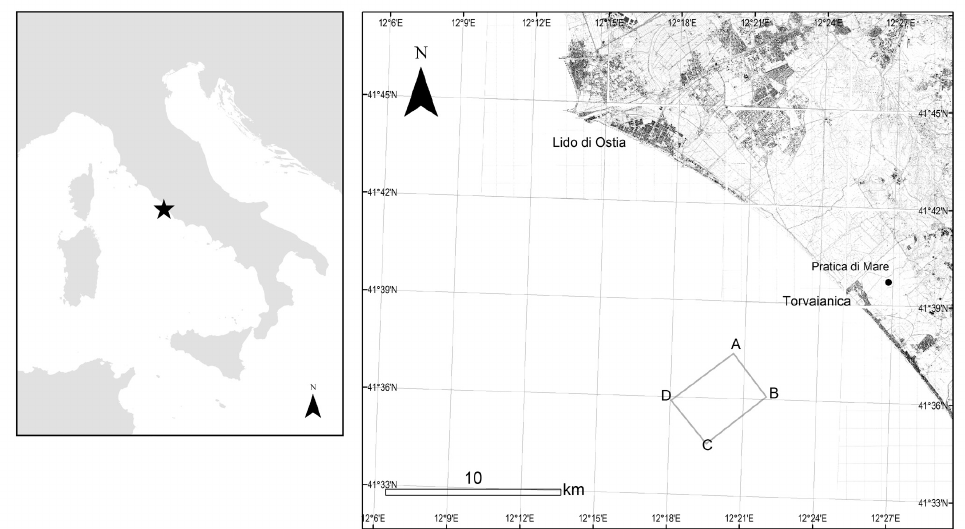
Fig. 1 – Study area; the rectangle A-B-C-D marks the borders of the Marine Protected Area “Secche di Tor